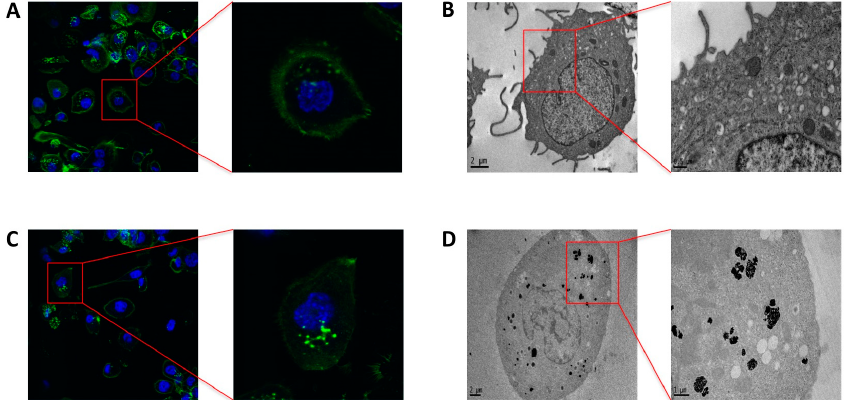
Figure 2. Confocal and transmission electron microscopy images of untreated ( A , B ) and PtNP pre-